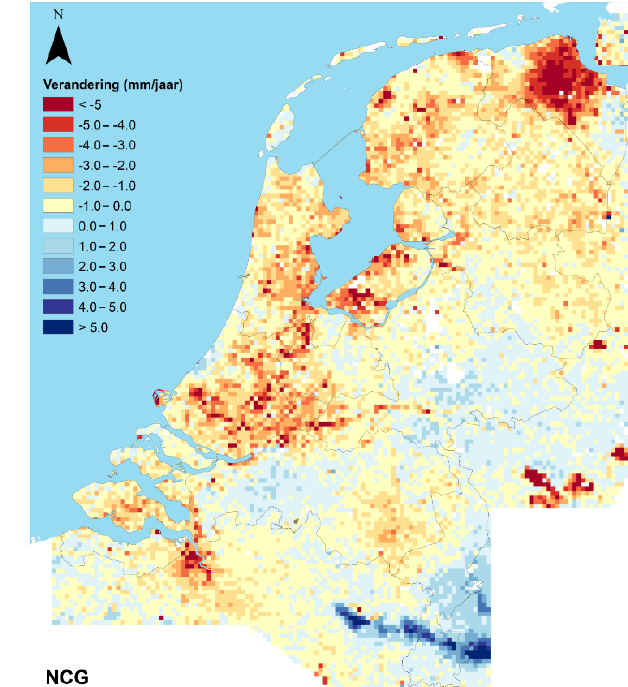
Figure 3. Land subsidence rates in the Netherlands (2015–2018). This product is an example where multiple measurement tech- niques were combined, in this case Persistent Scatterer InSAR, GNSS and gravimetry. Map downloaded in 2019 from https:// bodemdalingskaart.nl/ and produced by the Nederlands Centrum voor Geodesie en Geo-Informatica (Dutch Geodetic Centre, NCG). Verandering (mm/jaar) = Deformation